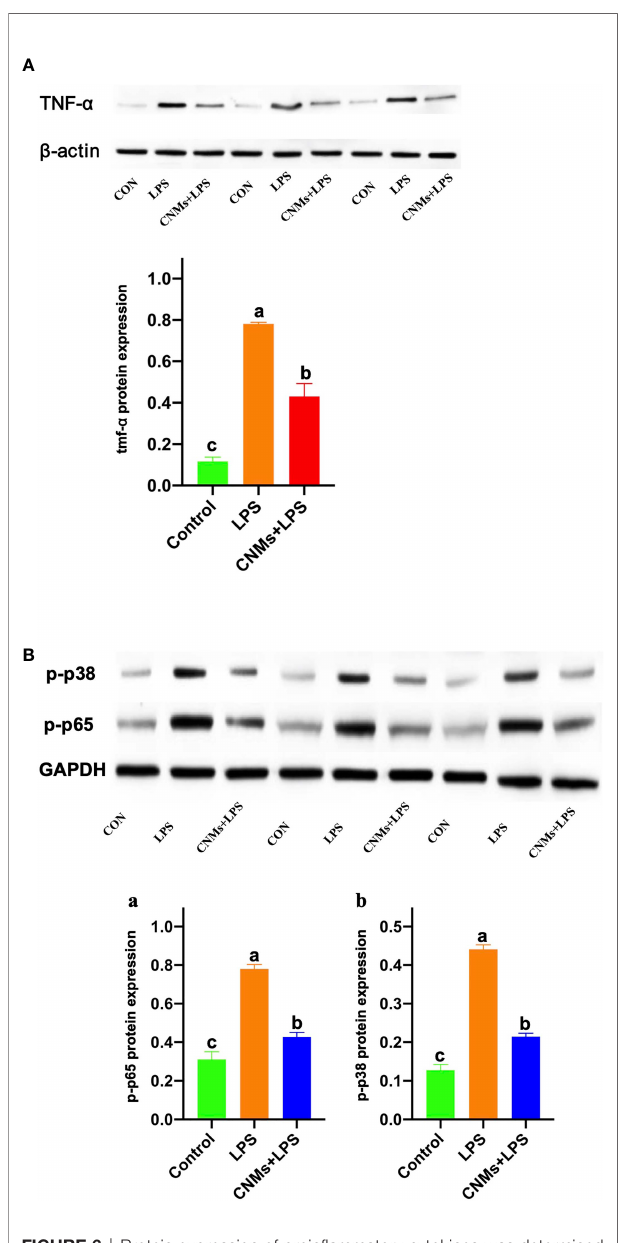
FIGURE 6 | Protein expression of proin fl ammatory cytokines was determined by Western blotting. Cells were treated with 1 µg/ml LPS and incubated with CNMs at 0.05% concentrations. Cells in different treatments were collected at 24 h after culture. The TNF- a , p-p38 MAPK, and p-NF- k B protein expression was analyzed by Western blotting in RAW264.7 cells. RAW264.7 cells were pretreated or not with CNMs for 24 h and then challenged with LPS. Cells were collected after LPS challenge. (A) The abundance of TNF- a . (B) The abundance of phosphorylated NF- k B (a) and p-p38 (b) . The results were indicated as means ± standard error. Different superscript lowercase letters among groups indicate signi fi cant differences ( p <